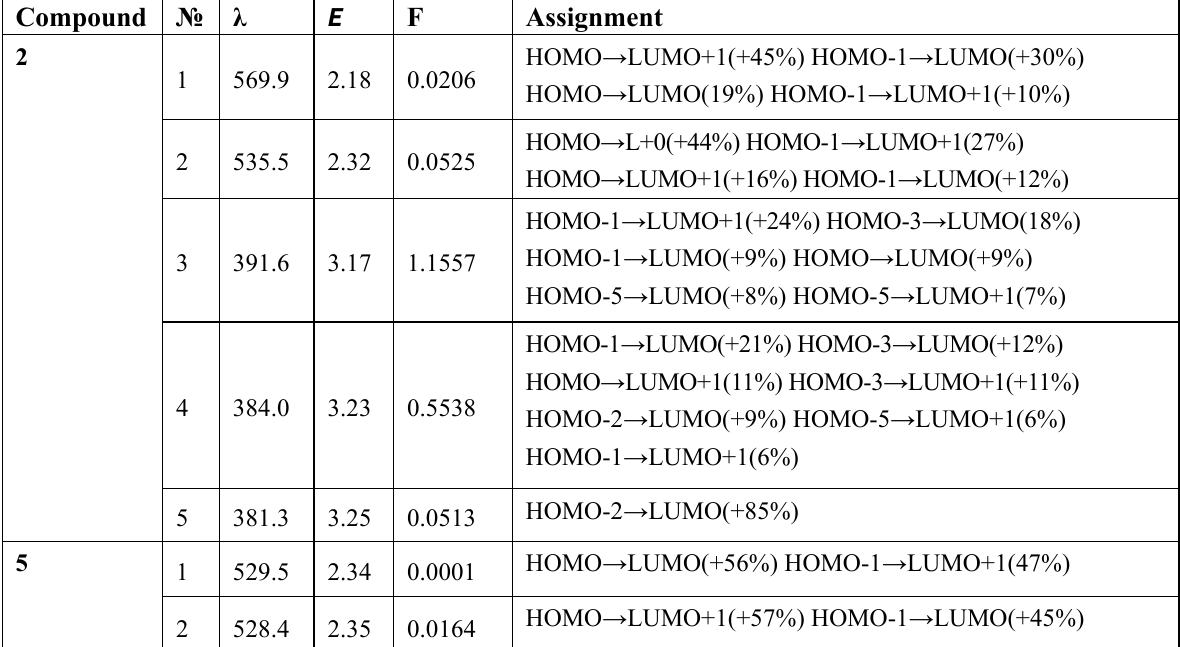
Table 3. Wavelengths ( λ , nm) of transitions, their energies E (eV), assignment and oscillator strengths ( f ) in electronic absorption spectra of compounds 1–6 calculated with B3LYP level of